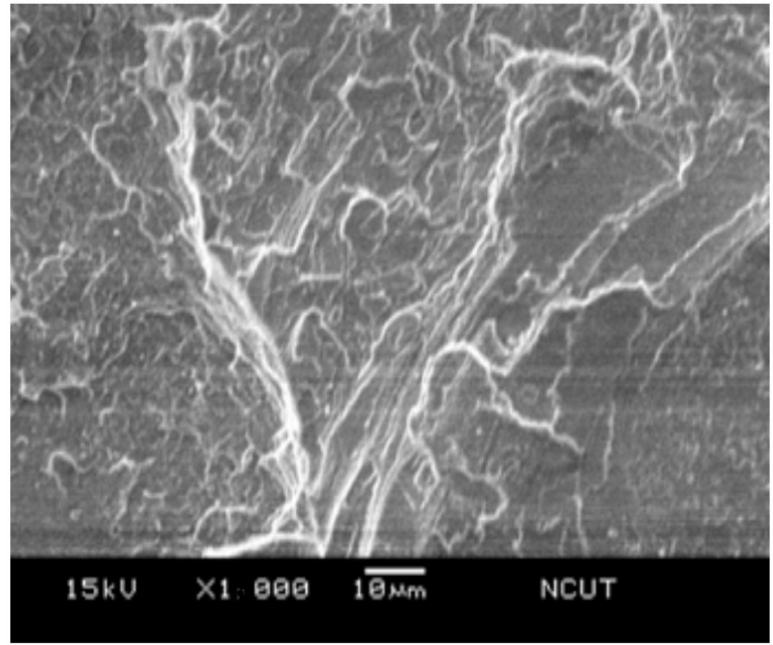
Figure 14. SEM micrograph of the fractured surface on NPS sample.